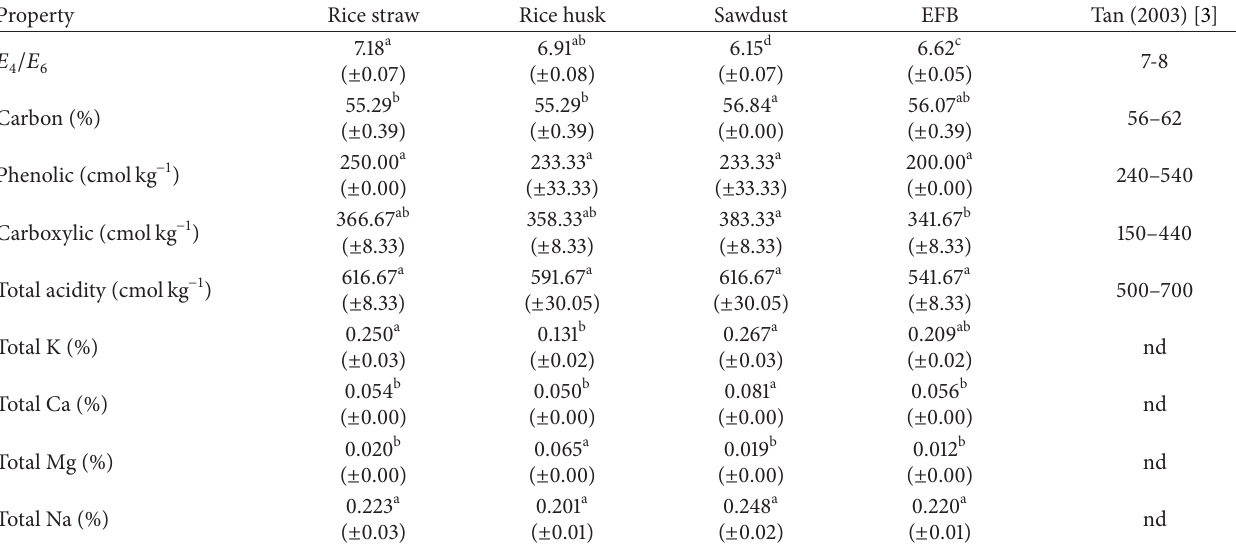
Table 5: Chemical properties of humic acids from different composts.